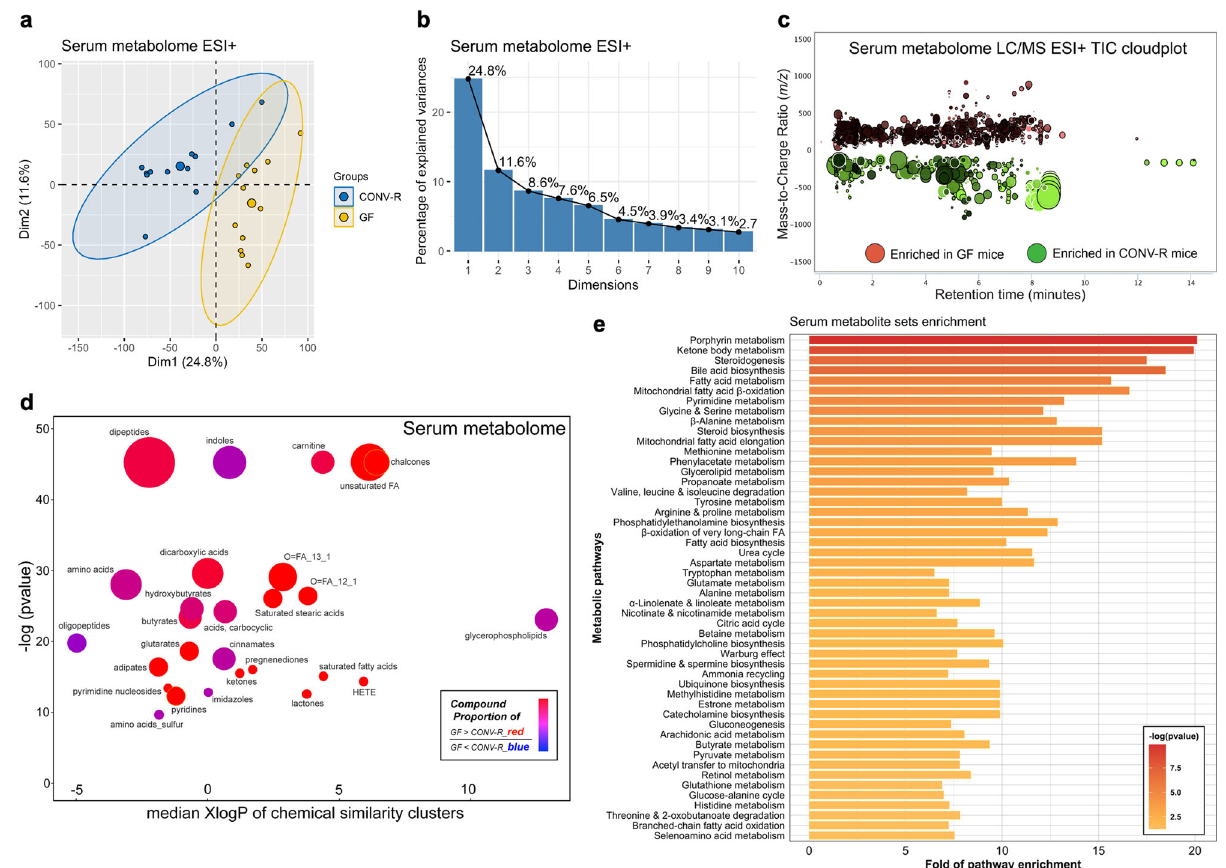
Fig. 5 Global effects of microbiota on host circulating blood metabolism. a, b Principal component analysis score plot ( a ) and scree loading plot ( b ) for assessing serum metabolomic data comparing GF ( N = 12) and CONV-R mice ( N = 12) under heated ESI + mode. c Metabolomic total ion chromatogram cloudplot of signi fi cant features in serum between groups ( p value < 0.01, fold change ≥ 1.5, two-sided Welch ’ s t test) using heated ESI + as an example; larger circle size indicated larger fold change values ranging from 1.5-1,347.1. d Chemical similarity enrichment analysis (ChemRICH) clustering of 231 identi fi ed altered serum metabolites by chemical similarity with x -axis of mediation logarithmic additive octanol-water partition coef fi cients (XlogP) and y - axis for sets statistical signi fi cance based on the Kolmogorov – Smirnov test; the node size depicted total compound numbers for each cluster set and node color scale the proportion of GF-enriched vs. CONV-R enriched metabolites. e Quantitative metabolite set enrichment analysis (qMSEA) based on 99 a priori de fi ned sets of metabolites identi fi ed a total of 57 signi fi cantly perturbed serum metabolic pathways (adjusted p < 0.05) with top 50 shown. LC/MS liquid chromatography-mass spectrometry, TIC total ion chromatogram, HETE 5-hydroxyeicosatetraenoic acid, FA fatty